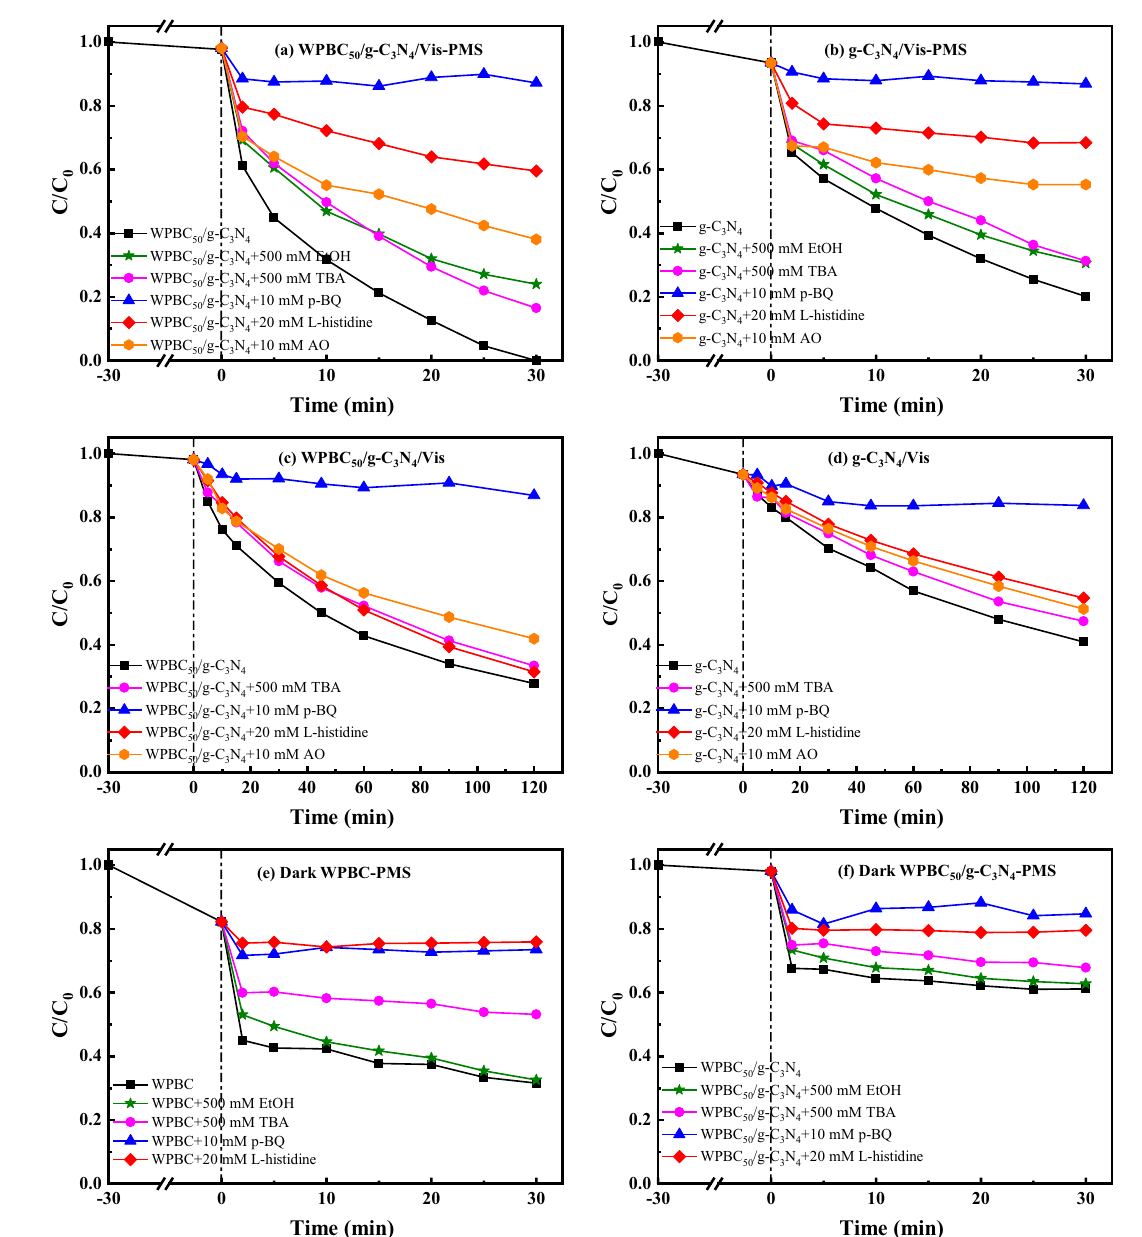
Fig. 6 Effects of different radical scavengers on DCF degra- dation in a WPBC 50 /g-C 3 N 4 /Vis-PMS, b g-C 3 N 4 /Vis-PMS, c WPBC 50 /g-C 3 N 4 /Vis, d g-C 3 N 4 /Vis, e dark WPBC-PMS and f